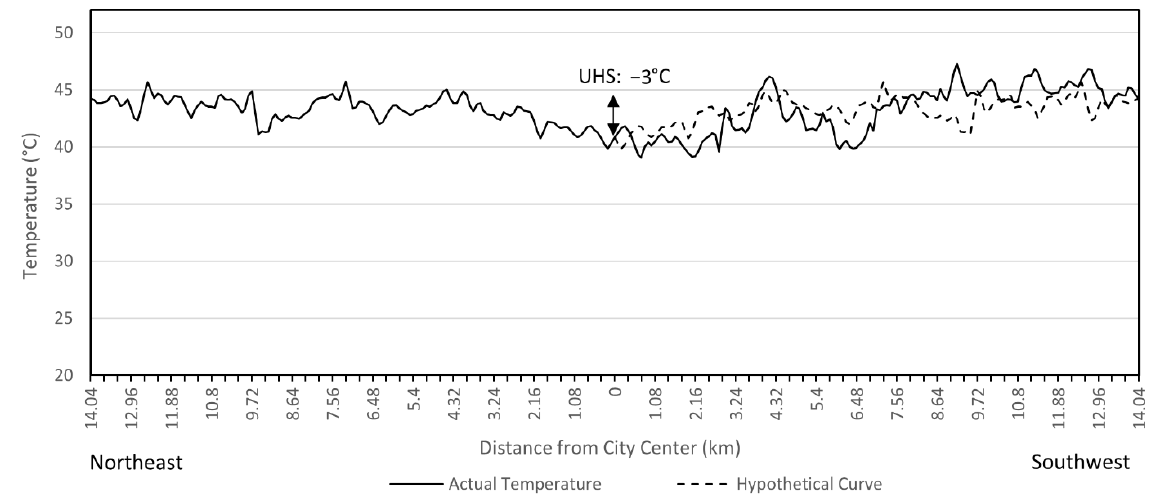
Figure 8. Surface temperature cross section along a northeast-southwest transect parallel to the coastline and across the city of Casablanca.